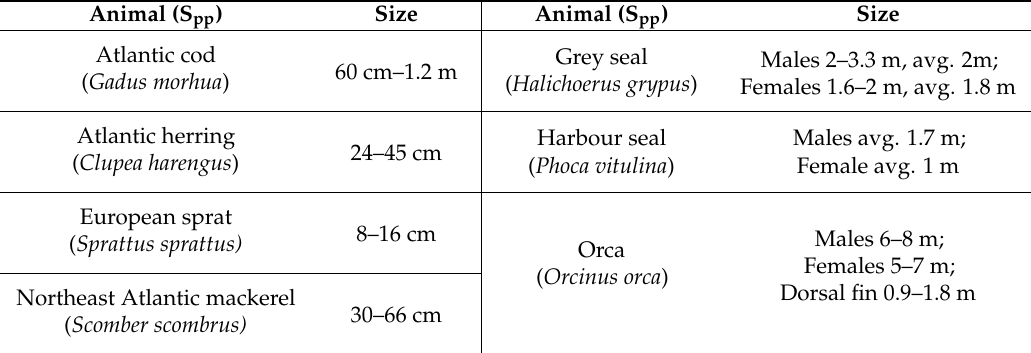
Table 3. Expected target size of marine animals, values retrieved from the literature